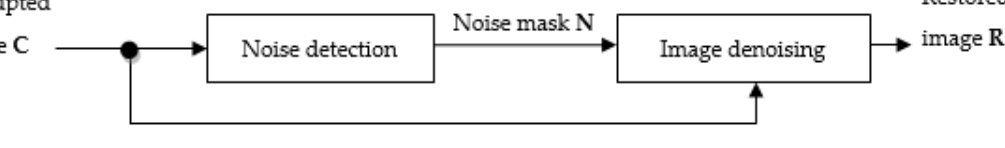
Figure 1. General flow of the proposed method .